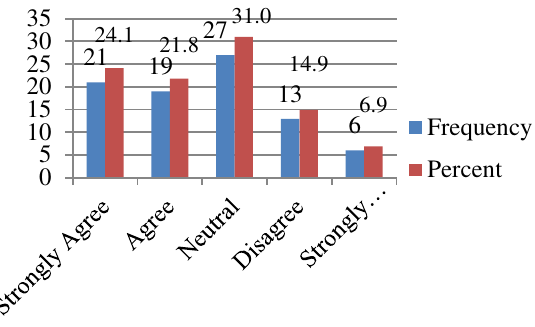
Fig. 5. Respondent’s perception on product can solve the problem of dissatisfaction Figure 5 indicates that the majority of